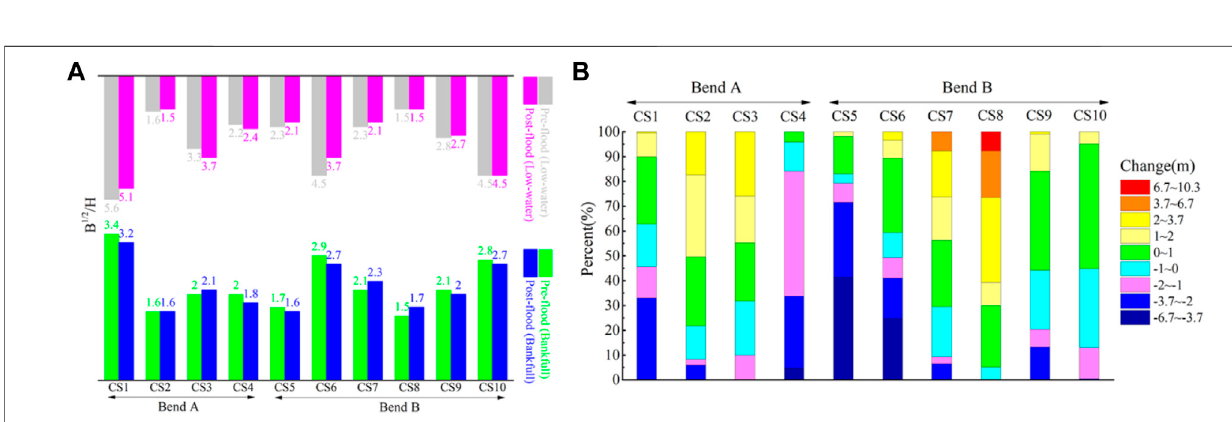
Frontiers in Earth Science |